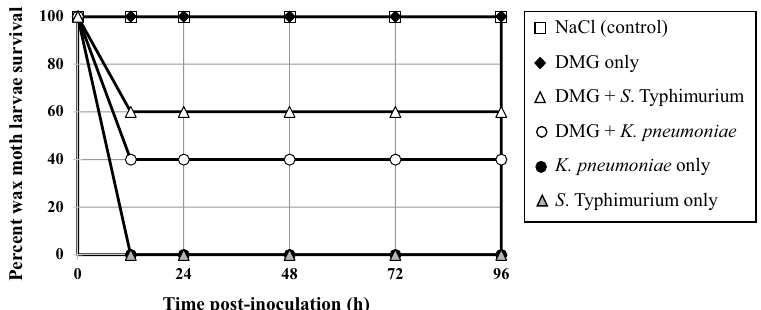
Figure 5. DMG-treatment attenuates virulence of MDR K. pneumoniae and MDR S . Typhimurium in the Galleria mellonella insect model. G. mellonella larvae (n = 10 for each condition) were inoculated with 5 μ L of the following: 0.8% NaCl (control); 250 mM DMG; 5 × 10 5 CFUs K. pneumoniae BAA2472; 250 mM DMG (left proleg) and 5 × 10 5 CFUs K. pneumoniae BAA2472 (right proleg); 5 × 10 5 CFUs S . Typhimurium 700408; 250 mM DMG (left proleg) and 5 × 10 5 CFUs S . Typhimurium 700408 (right proleg); as indicated on the